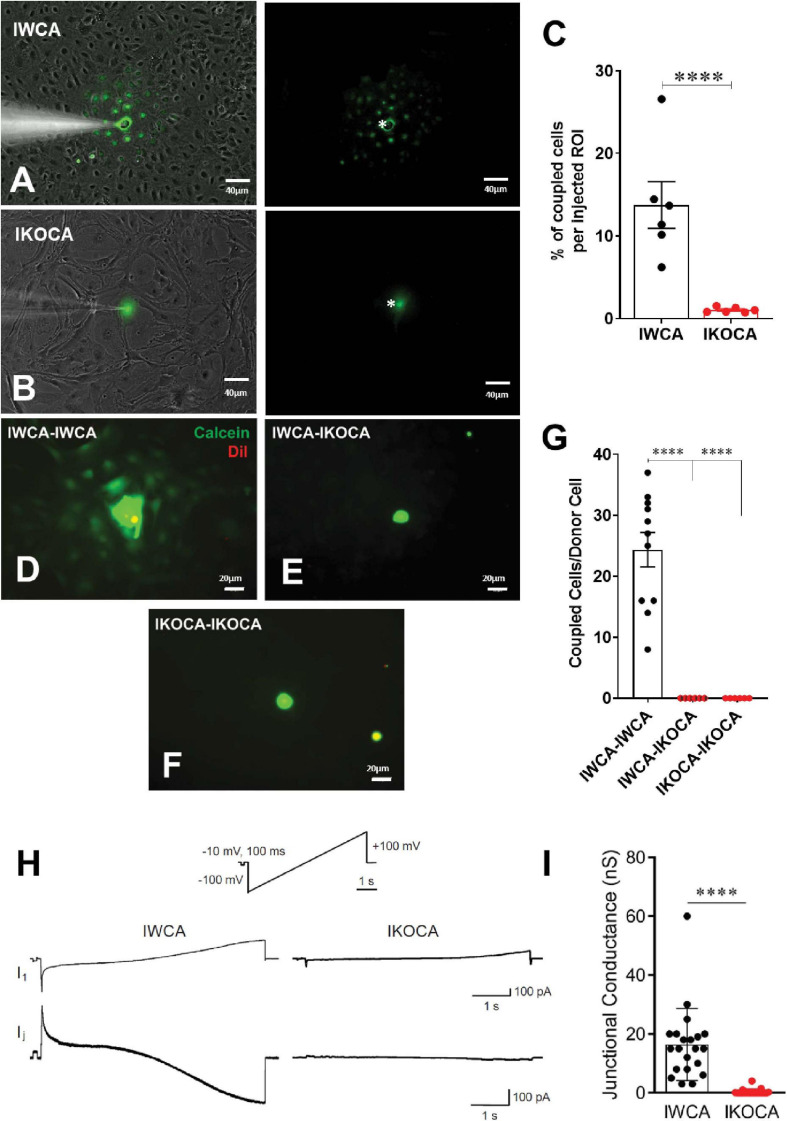
Assessment of functional GJ coupling in immortalized WT (IWCA) and Cx43-null (IKOCA) in confluent cortical astrocyte cultures. (A) Lucifer Yellow (LY) dye coupling between IWCA observed at passage 10. Left, bright phase contrast image of the field of view, with superimposed fluorescence. Right; fluorescence image with asterisk indicating the cell that was micro-injected with LY; note gap junction-mediated dye spread detected in all immediately adjacent neighbors. Scale bars = 40 μm (B). LY dye coupling was not observed between IKOCA at passage 10. Left, bright phase plus fluorescence showing field of view for injection. Right: In IKOCA cultures, the dye did not spread from the injected cell into the neighbor adjacent cells. Scale bars = 40 μm (C). Quantification of LY dye spread in IWCA and in IKOCA cultures. Bar histograms correspond to mean ± SEM of six injections per genotype performed in two independent cultures per genotype at passage 10 (****p < 0.001). (D–F). Parachute assay: (D) from IWCA passage 9 donor to recipient IWCA cells (IWCA-IWCA); (E) from IWCA donor to recipient IKOCA passage 10 cells (IWCA-IKOCA), and (F) from IKOCA passage 10 donor to recipient IKOCA cells. Donor cells were identified by double calcein-DiI (green and red, respectively) labeling. Scale bars = 20 μm (G) Quantification of calcein dye spread in IWCA-IWCA, in IWCA-IKOCA and in IKOCA-IKOCA donor-recipient cultures. Coupling was assessed as number of coupled cells per donor cell. (H) Junctional currents measured using dual whole cell voltage clamp between IWCA and IKOCA cell pairs. Slow voltage ramp (inset, –100 mV to +100 mV over 5 s) was delivered to cell one, while recording currents in cell one (I1, upper traces) and cell two (current recorded in cell two while delivering voltage to cell one is equivalent, but opposite in polarity, to junctional current and is labeled Ij). Junctional current from IWCA pairs (lower left trace) are large and show non-linearity with respect to voltage that is consistent with voltage dependence of Cx43 channels. Junctional current from IKOCA pair is quite small, indicating that cells are not highly coupled. (I) Quantification of junctional conductance (gj = Ij/V) in IWCA and IKOCA cell pairs. Note significantly stronger gj in WCA compared to IKOCA (17.35 + 3.2 nS, N = 17 vs 0.36 + 0.18 nS, N = 23; p < 0.0001).